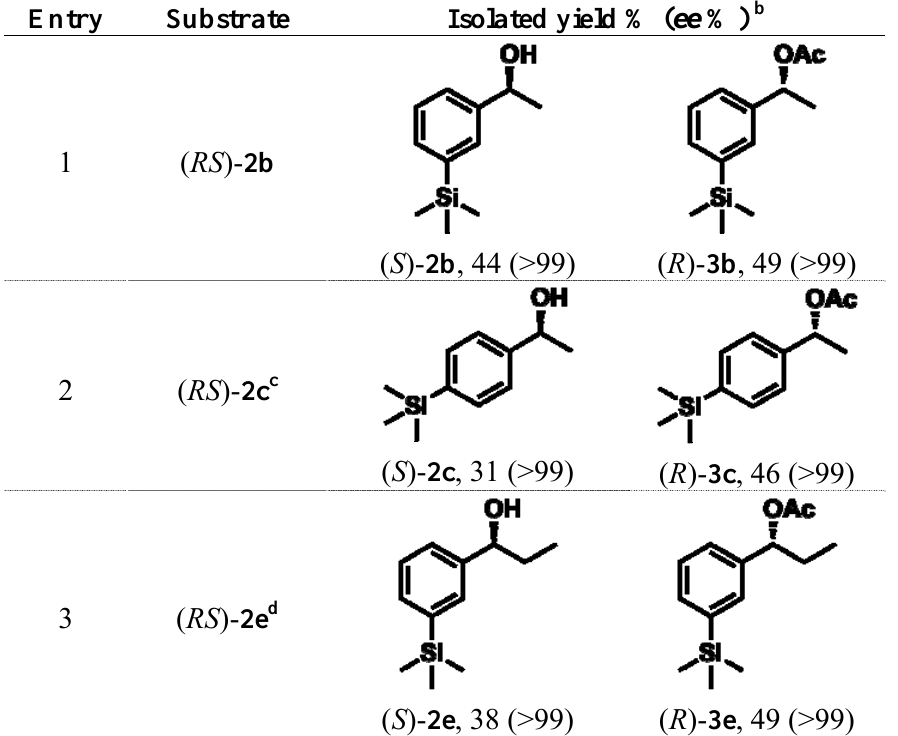
Table 4. Lipase-catalyzed kinetic resolution of compounds ( R,S )- 2b , c and ( R,S )- 2e , f a